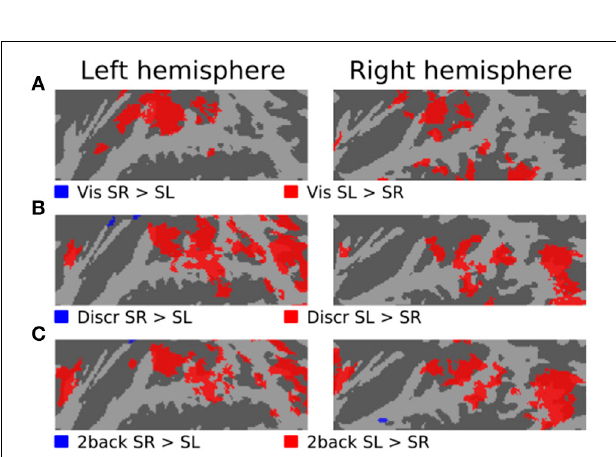
FIGURE 3 | Comparisons of activations during visual, discrimination and 2-back tasks with SD and SL sounds.